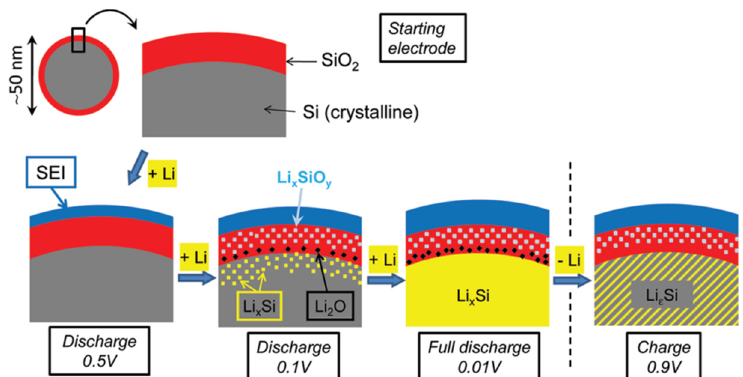
Figure 3. The crystalline structure of SiO 2 ( P 3121 space group) drawn via the VESTA method ( a ) with O vacancy, ( b ) with Si vacancy, and ( c , d ) with empty sites. Reproduced with permission from ref. [1]. Copyright 2011, The Ceramic Society of Japan.